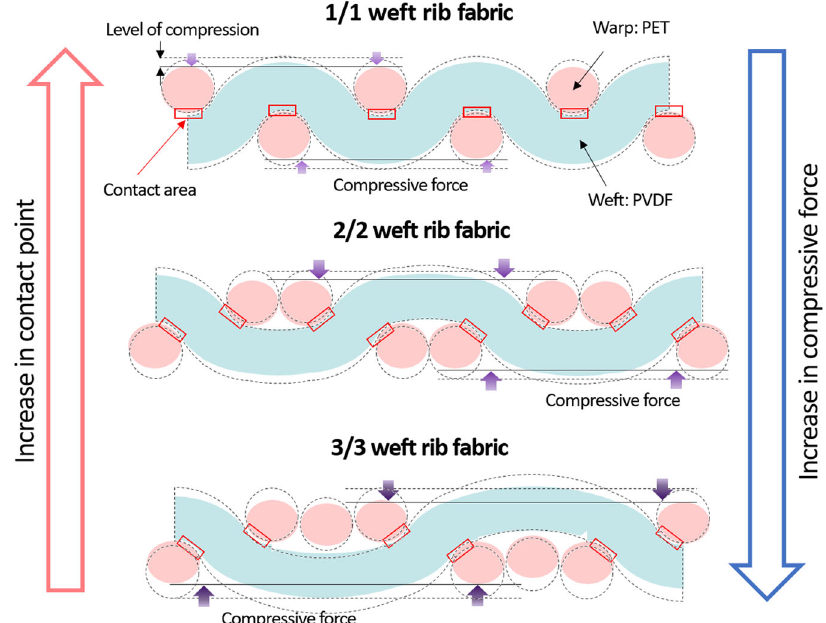
Fig. 4 Mechanism inducing piezoelectricity in different weave patterns. Potential mechanism of generating piezoelectricity, which implies the optimal performance of the 2/2 weft rib pattern due to the balance between the effects of the number of contact points and the magnitude of compressive